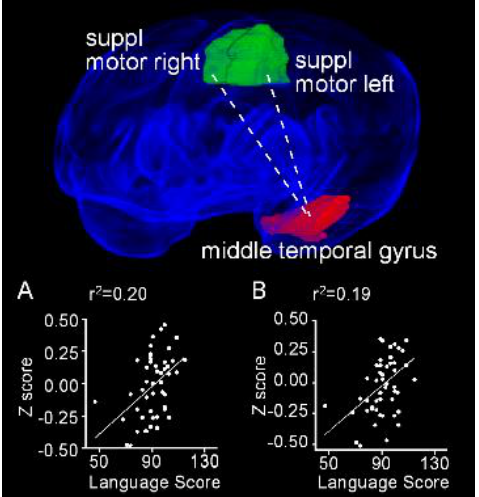
Figure 10. Resting state functional connectivity between the left middle temporal gyrus and both right and left supplementary motor areas exhibit positive linear relationships with performance on the language subscale of the Bayley III. Obliquely projected 3D reconstruction of the MRI images of cerebral grey matter and identified parcellated regions derived from a neonatal atlas. Dashed white line depicts the connectivity relationship. Inset: Individual Fisher-transformed Z scores of the correlation coefficients between regions. ( A ) Middle temporal gyrus and right supplemental motor area. ( B ) Middle temporal gyrus and left supplemental motor area.